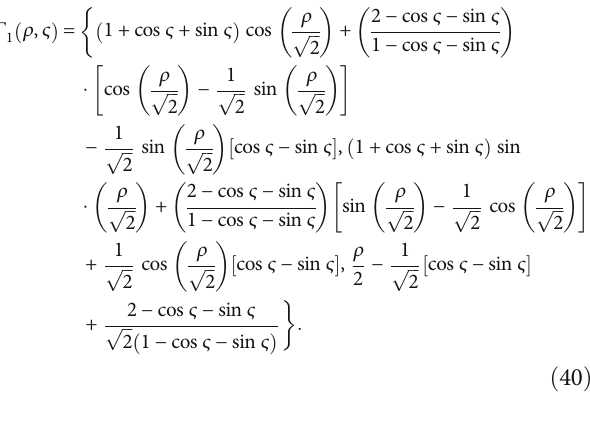
Figure 4: Harmonic surface Γ